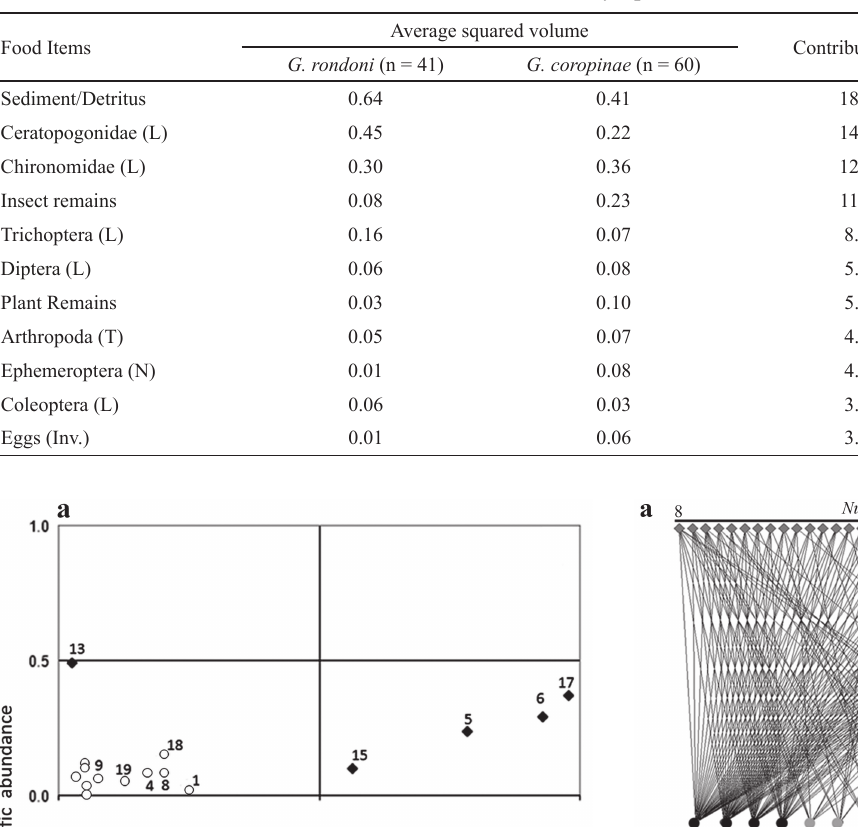
Tab. 2. Food items that accounted for the differences in the diet composition of Gymnorhamphichthys rondoni and Gymnotus coropinae based on the Similarity Percentage Analysis in first to third order streams at the Saracá-Taquera National Forest, Oriximiná, Pará. Codes: Inv.- Invertebrate; L - Larvae; N - Nymphs; and T -